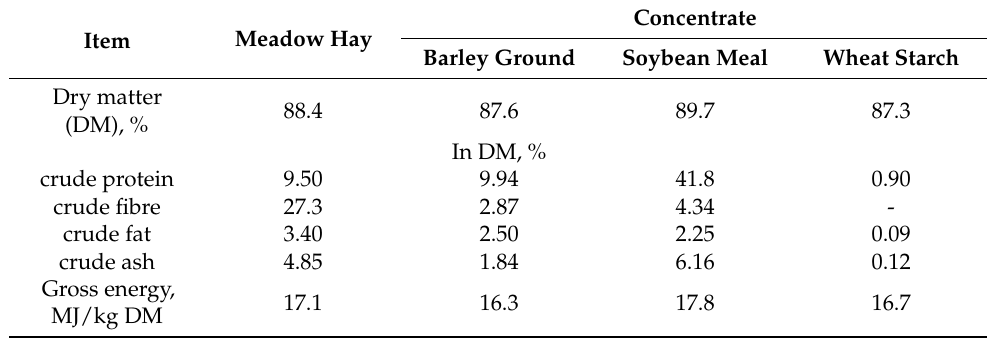
Table 2. Chemical composition and energy values in the ingredients of diets. Item